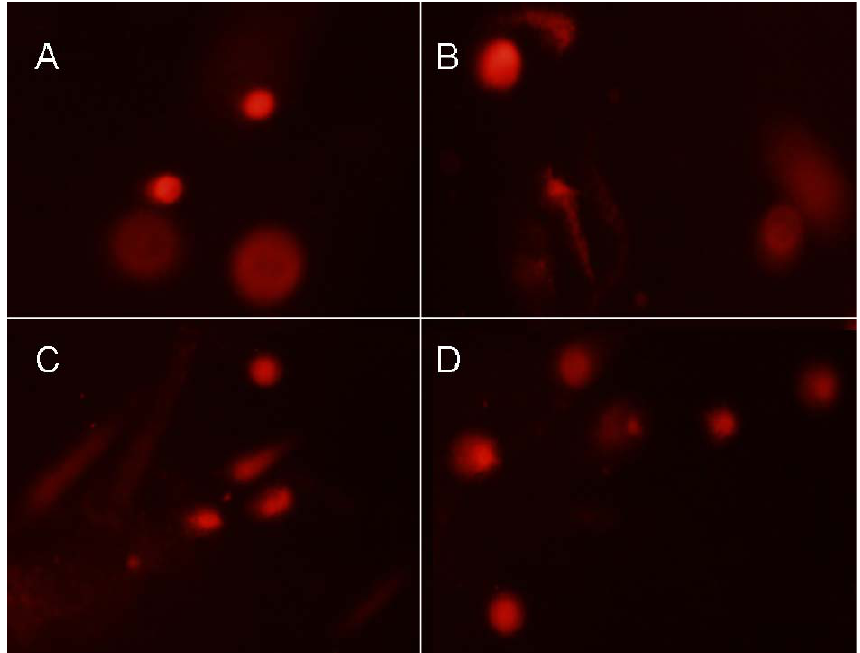
Figure 4. Representative photomicrographs showing the DNA migration pattern in NHBE cells: ( A ) control group; ( B ) treatment group with 10% CSE for 24 h; ( C ) treatment group with 10% CSE + UA (6.3 µmol/L) for 24 h; ( D ) treatment group with 10% CSE + UA (12.5 µmol/L) for 24